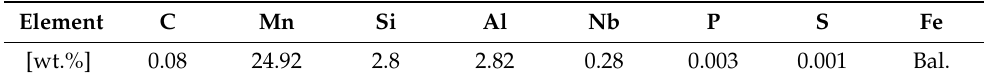
Figure 1. Microstructure of Fe-25Mn-3Si-3Al-0.3Nb steel after solution treatment. Table 1. Chemical composition of the experimental steels.